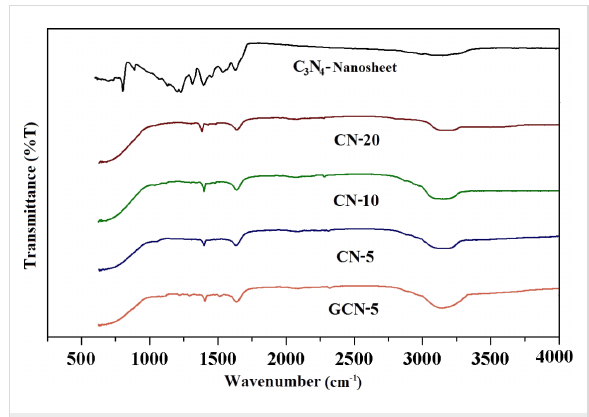
Figure 4: Fourier transform infrared spectra of the prepared g-C 3 N 4 , CN nanoflakes and quantum dots, and GCN-5 photocatalysts.